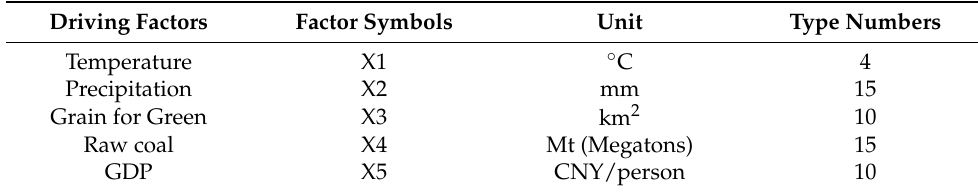
Figure 17. Q value of X1–X5. Table 5. Driving